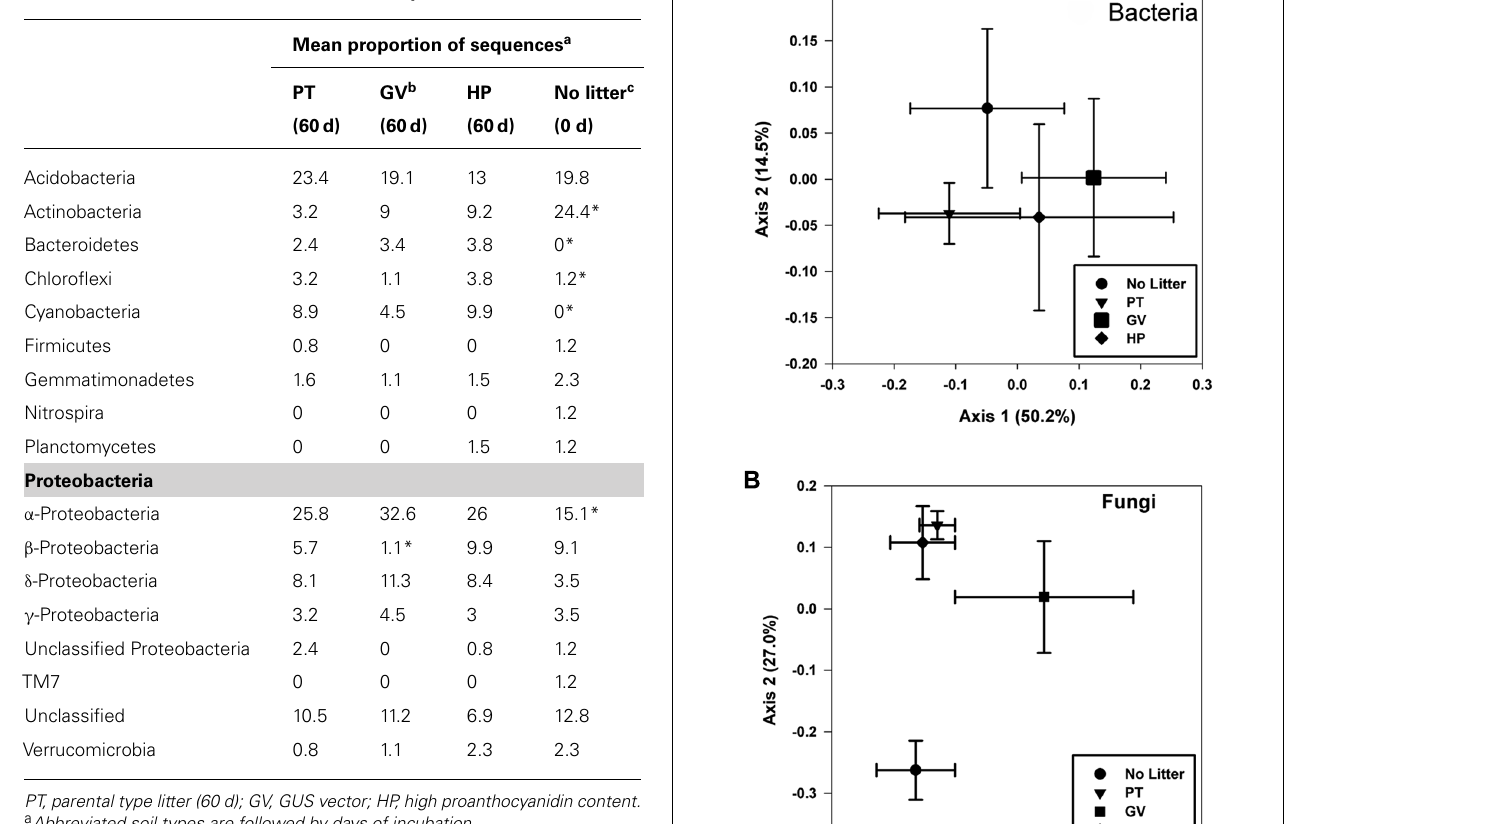
Table 4 |Taxonomic classification of 16S rDNA sequences in microcosms with soil and leaf litter from Populus tremuloides .